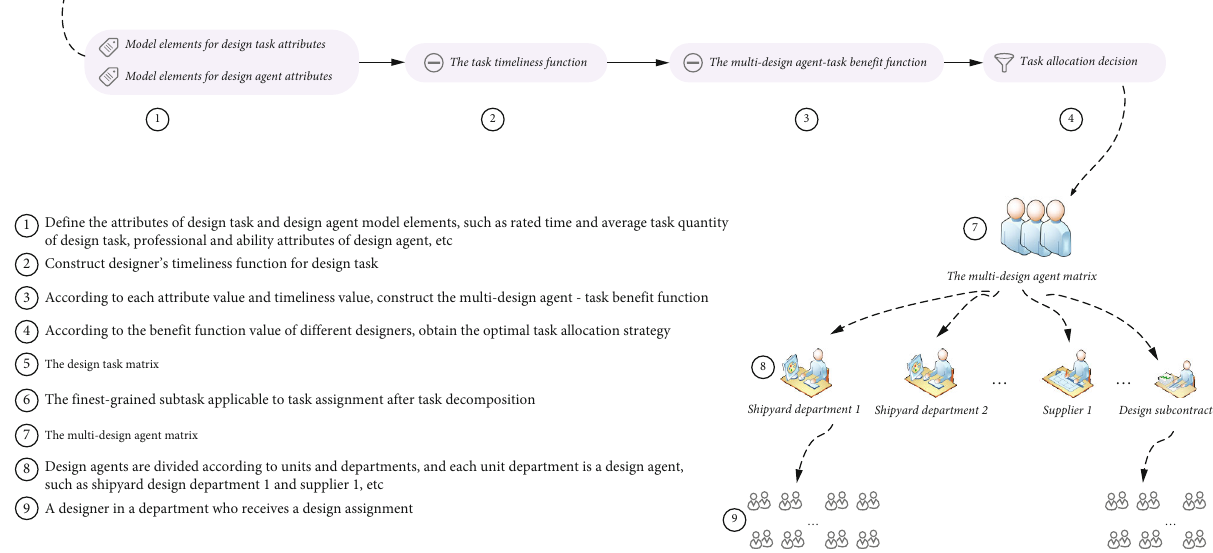
Figure 1: The decomposition logic diagram of the multidesign agent-task allocation decision-making